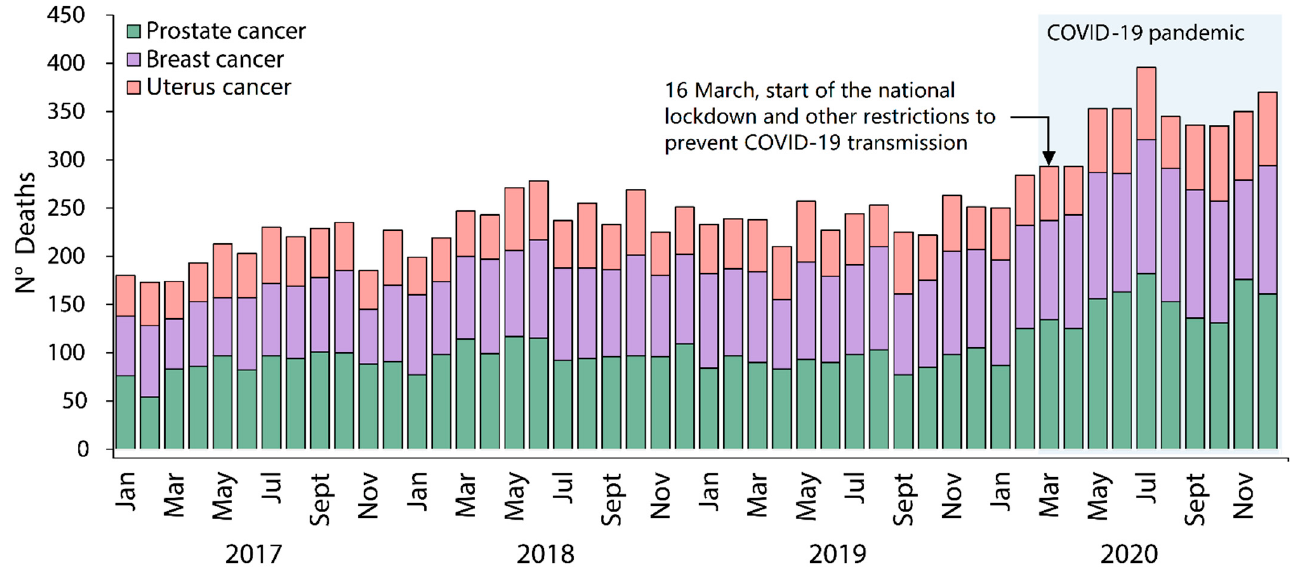
Figure 2. Trends in monthly observed deaths for prostate, breast, and uterus cancer between 1 Jan-